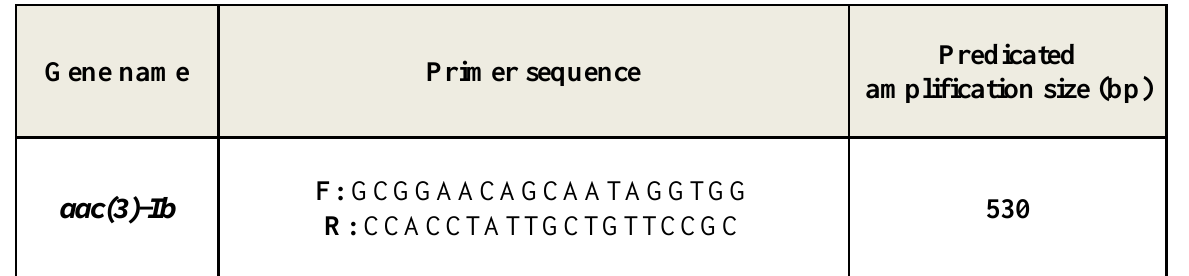
Table 1. Specific primers for a resistant gene in P. aeruginosa